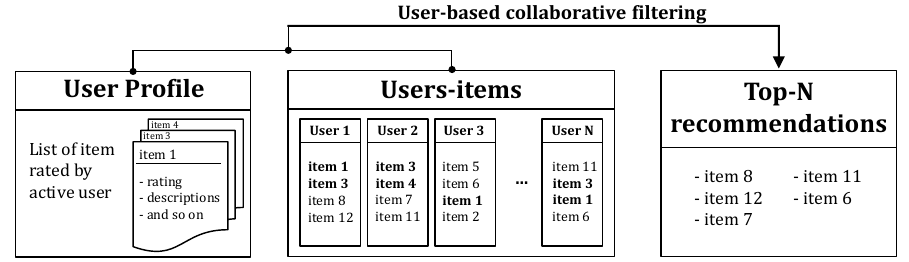
Figure 1. User-based collaborative